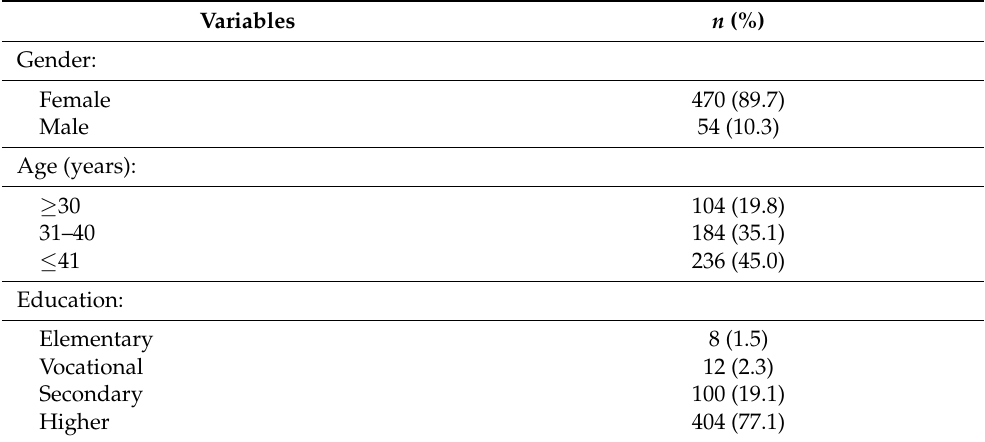
Table 1. Characteristics of the researched group ( n =